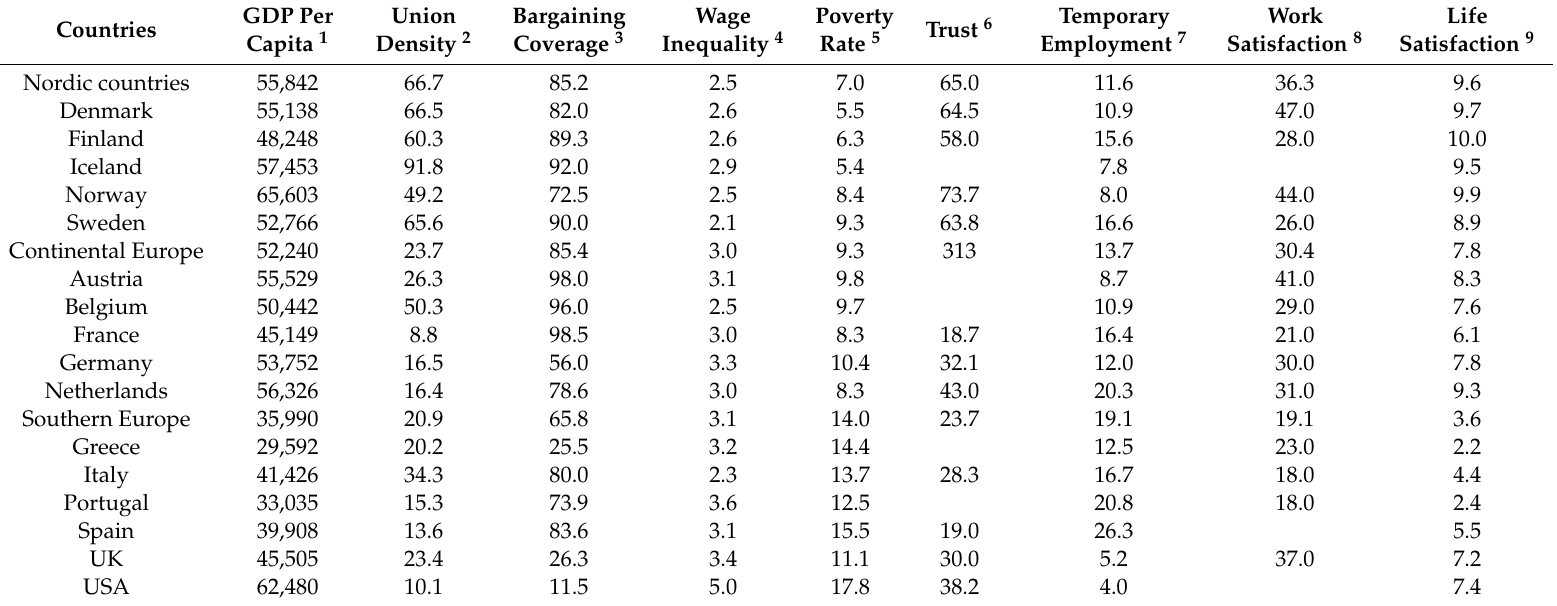
1 Gross domestic product (GDP) per capita in US dollar, converted to international dollars using purchasing power parity rates, 2018. Source: OECDi Library . 2 Trade union density corresponds to the ratio of wage and salary earners that are trade union members, divided by the total number of wage and salary earners, 2018. Source: OECDi Library . 3 Collective bargaining coverage rate expresses the number of workers covered by one or more collective agreements as a percentage of the total number of workers, 2016. Source: OECD. Stat . 4 Dispersion of pre-tax hourly wages measured by the 90–10 ratio. The ratio shows the income level of individuals at the top of the income distribution (top 10%) relatively to the income level of those at the bottom of the distribution (bottom 10%), 2018. Source: OECD Earnings Distribution Database. 5 The number of people (in percent) whose income falls below half the median household income of the total population, 2017. Source: OECD. Stat . 6 Share of people agreeing with the statement "most people can be trusted”, 2009–2014. Source: World Value Survey. 7 Temporary employment includes workers whose job has a pre-determined termination date. Source: OECD. Stat . 8 Number of respondents who answer that they are “very satisfied with working conditions in my main paid job”, 2015. Source: Sixth European Working Conditions Survey. 9 Life satisfaction measures how people evaluate their life as a whole. Source: OECD Better Life